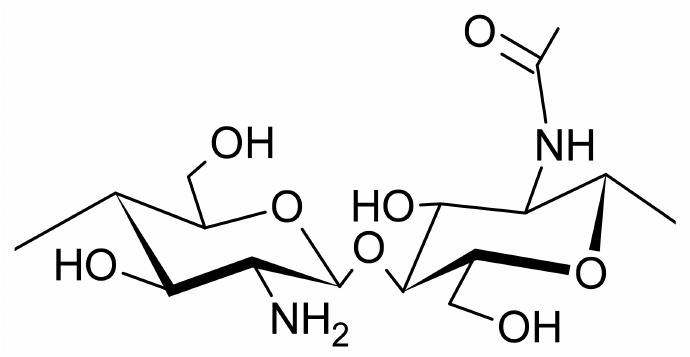
Figure 4. Chemical structure of